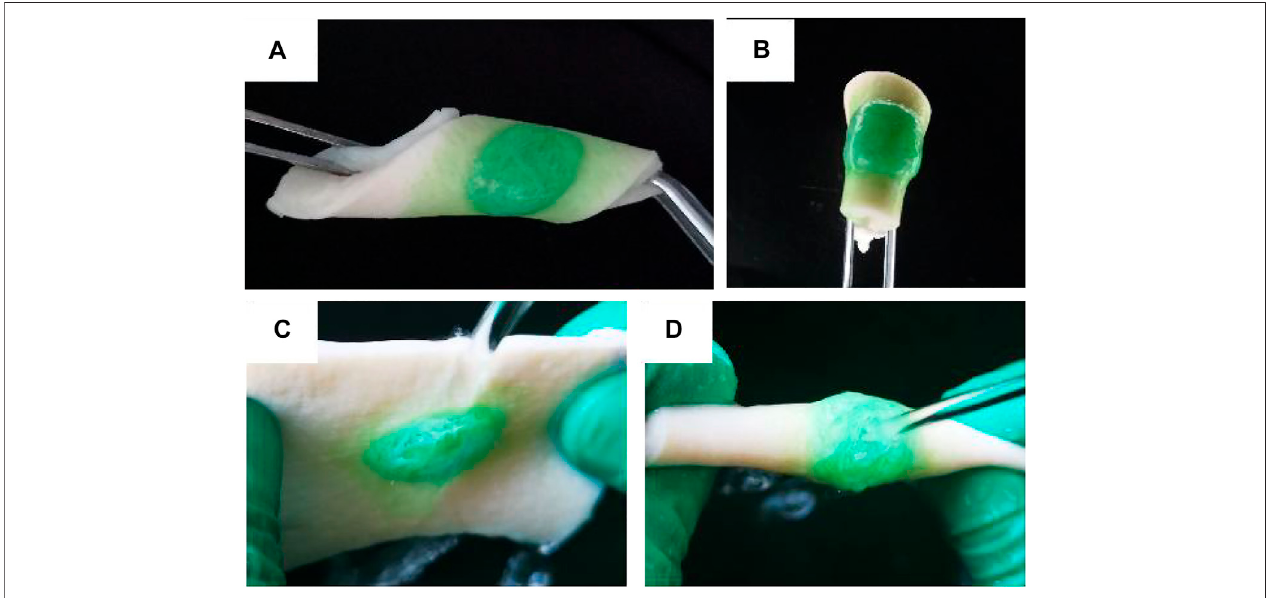
FIGURE 4 | Photo of OCP100 hydrogel adhered to the pigskin. (A) Side bending, twisting, and curling; (B) folding and twisting; (C) lateral water fl ow impact; (D) double water fl ow impact.